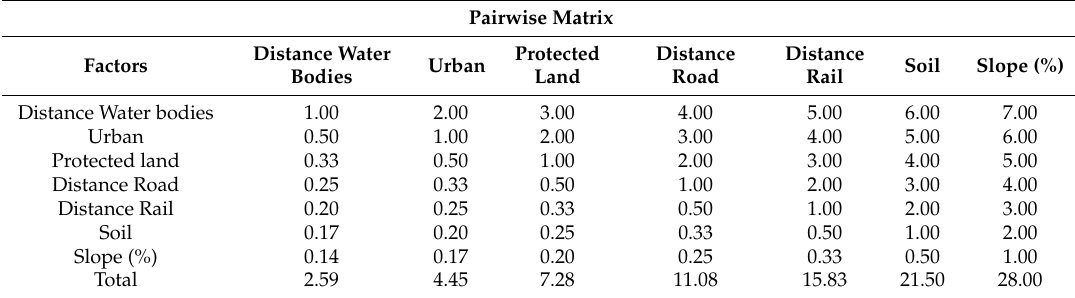
Table 3. Pairwise matrix for all the factors.